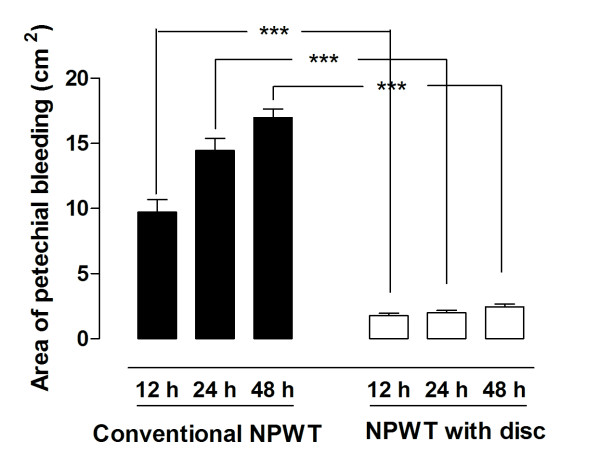
The area of petechial bleeding following NPWT at -120 mmHg after 12, 24, and 48 hours, with conventional NPWT and NPWT with a protective disc inserted between the intestines and the vacuum source. Results are presented as the mean of 6 values ± SEM. Statistical analysis was performed using the Mann-Whitney test. Significance was defined as p < 0.05 (*), p < 0.01 (**), p < 0.001 (***) and p > 0.05 (not significant, n.s.). The area of petechial bleeding was smaller when a protective disc was used during NPWT.